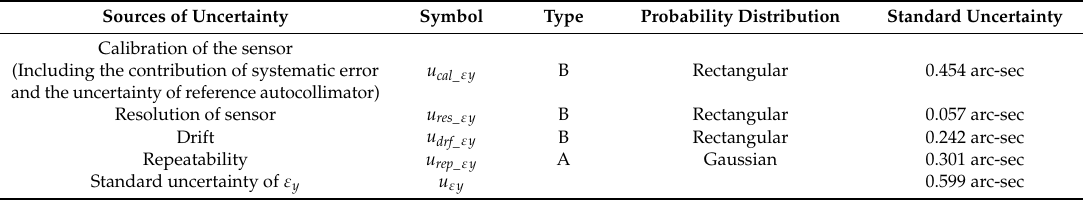
Table 2. Uncertainty of the inclination angle around the Y-axis of the proposed precision level. Sources of Uncertainty Symbol Type Probability Distribution Standard